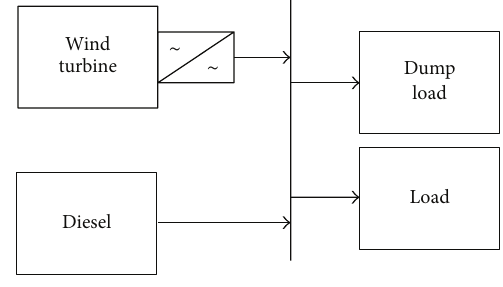
Figure 1: Wind/diesel